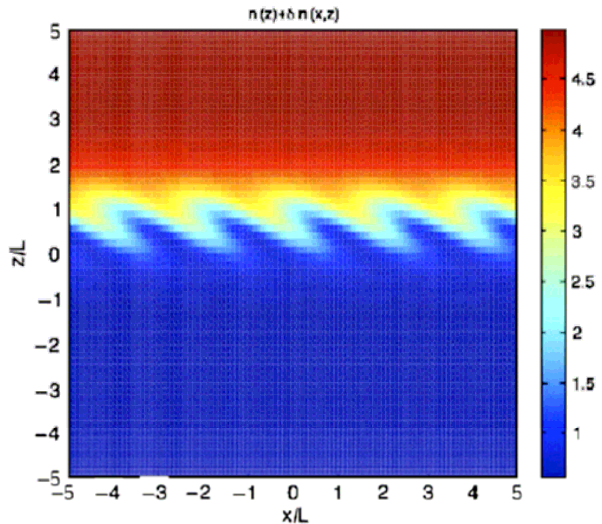
Fig. 21. Plasma density fluctuations resultant from a non-local lin- Figure 21. Plasma density fluctuations resultant from a non-local linear perturbation model of ear perturbation model of the “collisional shear instability”. Di- the “collisional shear instability”. Dimensions are normalized with respect to the gradient mensions are normalized with respect to the gradient scale length, L . For L =20km, a neutral wind of 200m/s, vertical drift of 20m/s, scale length, L. For L=20km, a neutral wind of 200 m/sec, vertical drift of 20 m/sec, gravity gravity included, the growth rate is equivalent to 18 e-folds in an hour. No zonal plasma drift (and no shear) is included (after Kudeki included, the growth rate is equivalent to 18 e-folds in an hour. No zonal plasma drift (and no et al., 2007). shear) is included. (After Kudeki et al., 2007). ical model, which includes an altitude dependent collision Figure 21. Plasma density fluctuations resultant from a non-local linear perturbation model of frequency and a neutral velocity shear decreases the growth rate (shear stabilizes the process), but comparable values are the “collisional shear instability”. Dimensions are normalized with respect to the gradient recovered when gravity and a typical zonal electric field is scale length, L. For L=20km, a neutral wind of 200 m/sec, vertical drift of 20 m/sec, gravity included. Figure 21 shows the plasma density solution un- included, the growth rate is equivalent to 18 e-folds in an hour. No zonal plasma drift (and no gradient scale length, 40 km. The 45 ◦ tilted quasi shear) is included. (After Kudeki et al., 2007).